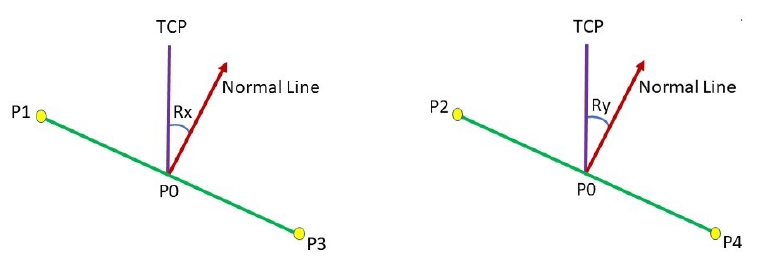
Figure 3. The deflection angle from TCP to normal